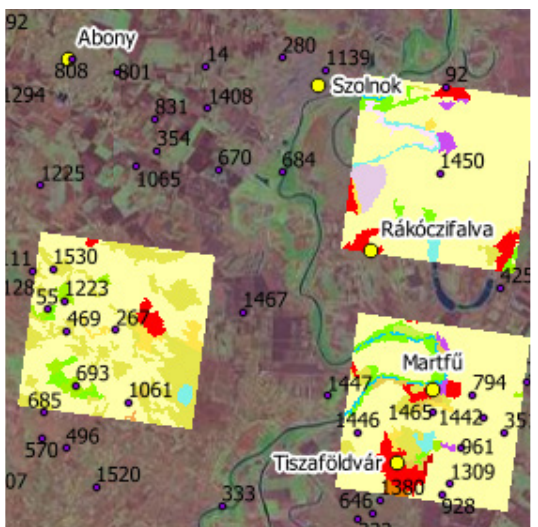
Figure 7. Some random worlds of the workspace, only three raster are displayed at scale 1:600 000 with Landsat TMS (Tile Map Service) on the